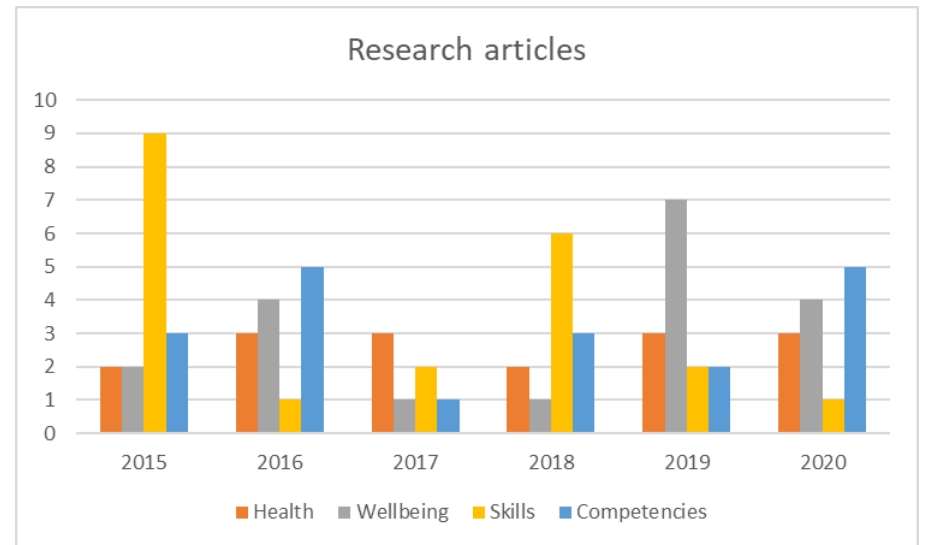
Figure 1. Number of Research Articles (2015-2020)